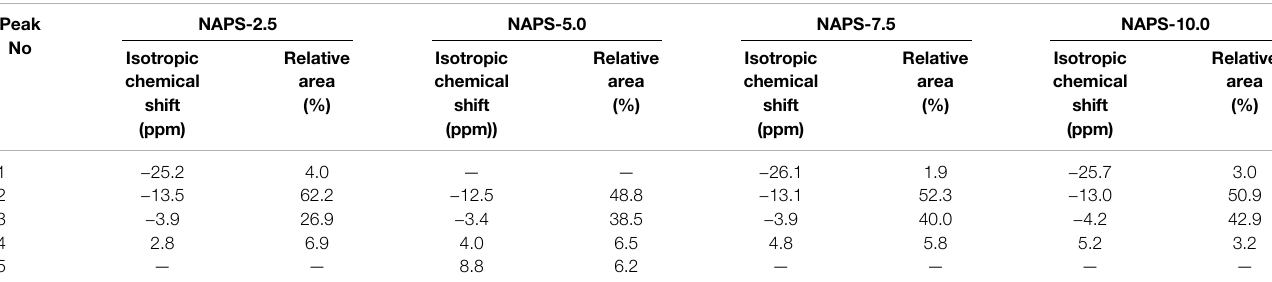
TABLE 3 | 31 P MAS – NMR deconvolution results using Gaussian model. Peak